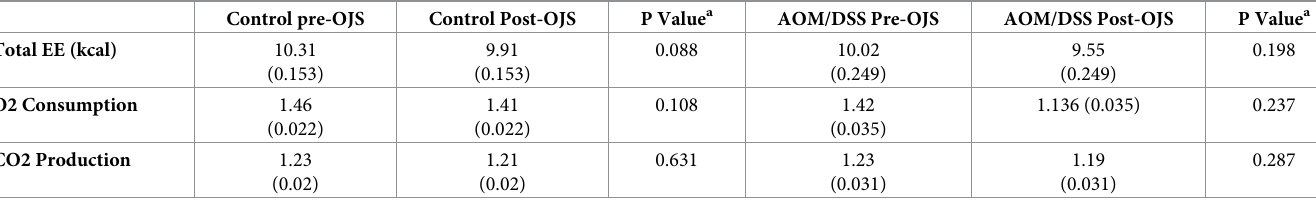
Table 1. Metabolic phenotyping of